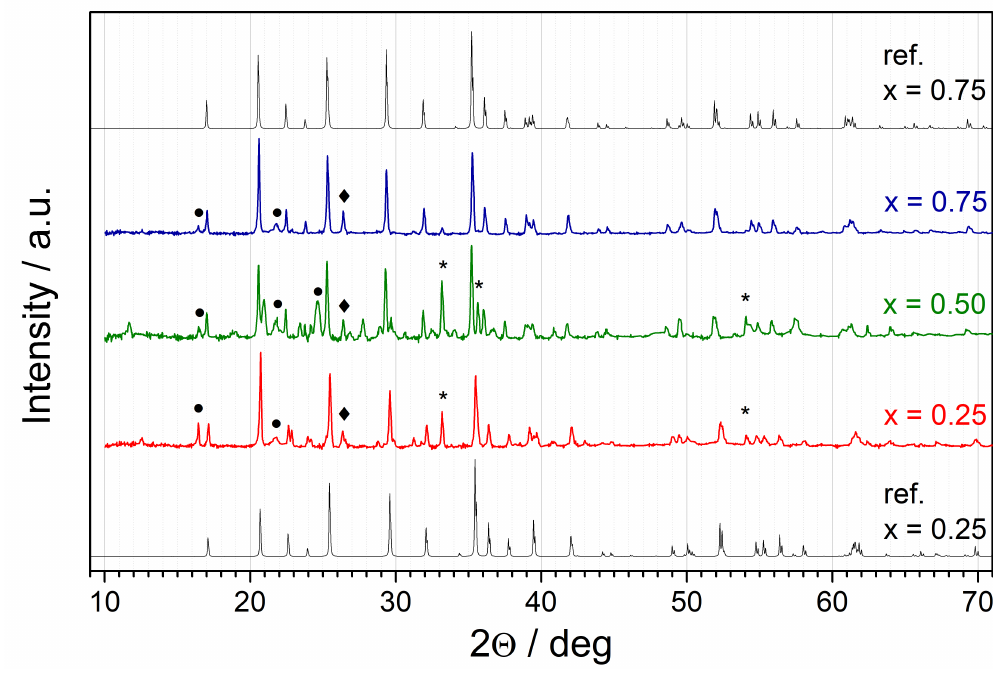
Figure 4. A comparison of the room temperature XRD patterns after heat-treatment at 580 °C for x = 0.25, 0.5, and 0.75. Reference patterns of Li(Fe 0.75 Mn 0.25 )PO 4 ( x = 0.25, at the bottom, ICDD card no. 00-066-0406) and Li(Fe 0.25 Mn 0.75 )PO 4 ( x = 0.75, at the top, ICDD card no. 04-024-8018) are provided for comparison. Major reflexes assigned to impurity phases are marked as follows: circle–Li 3 V 2 (PO 4 ) 3 (CIF no. 4124523), asterisk–Fe 2 O 3 (ICSD card no. 98-005-6372), diamond–V 2 O